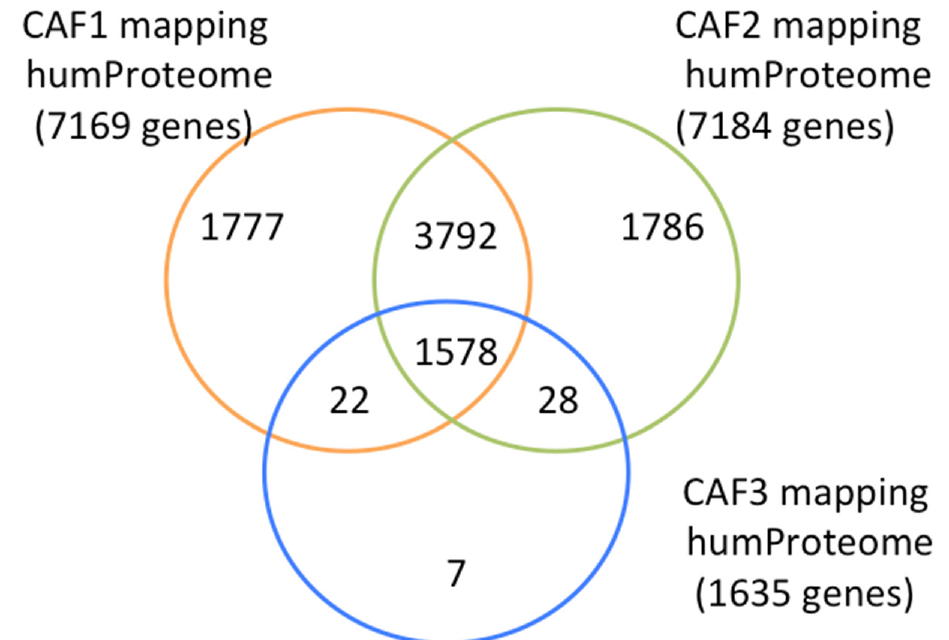
Figure 3. Venn diagram presentation of mappings of three CAF peptide repertoires on human proteome at threshold 0.68. The numbers of mappings for the retained proteins by three individual CAF peptide repertoires, the over-lapping of mapped proteins and the individually mapped proteins are indicated by inscribed numbers.